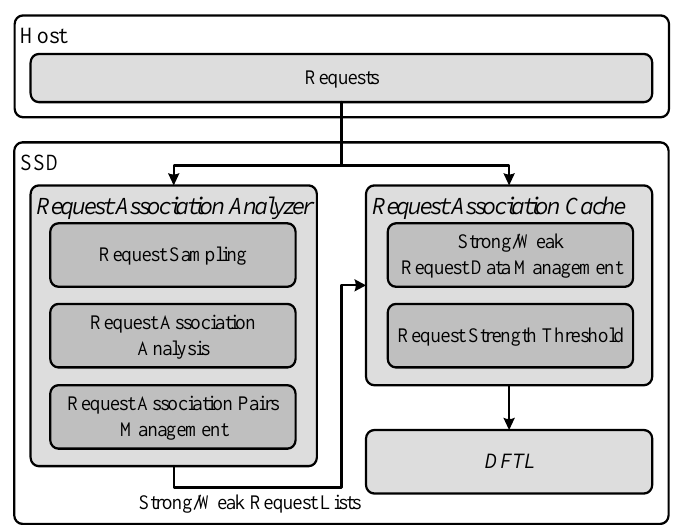
Figure 5. System